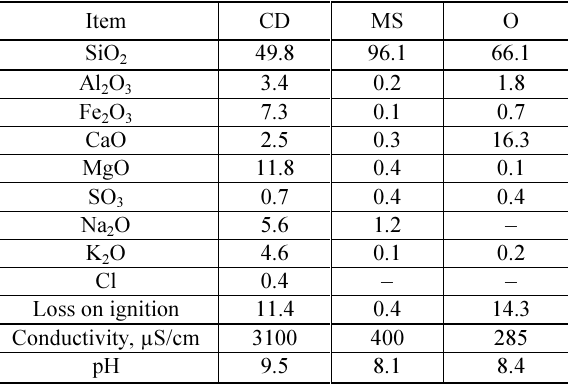
Fig. 2. Particle size distribution of non pre-dispersed P Table 1. Chemical composition (in %), conductivity and pH of P